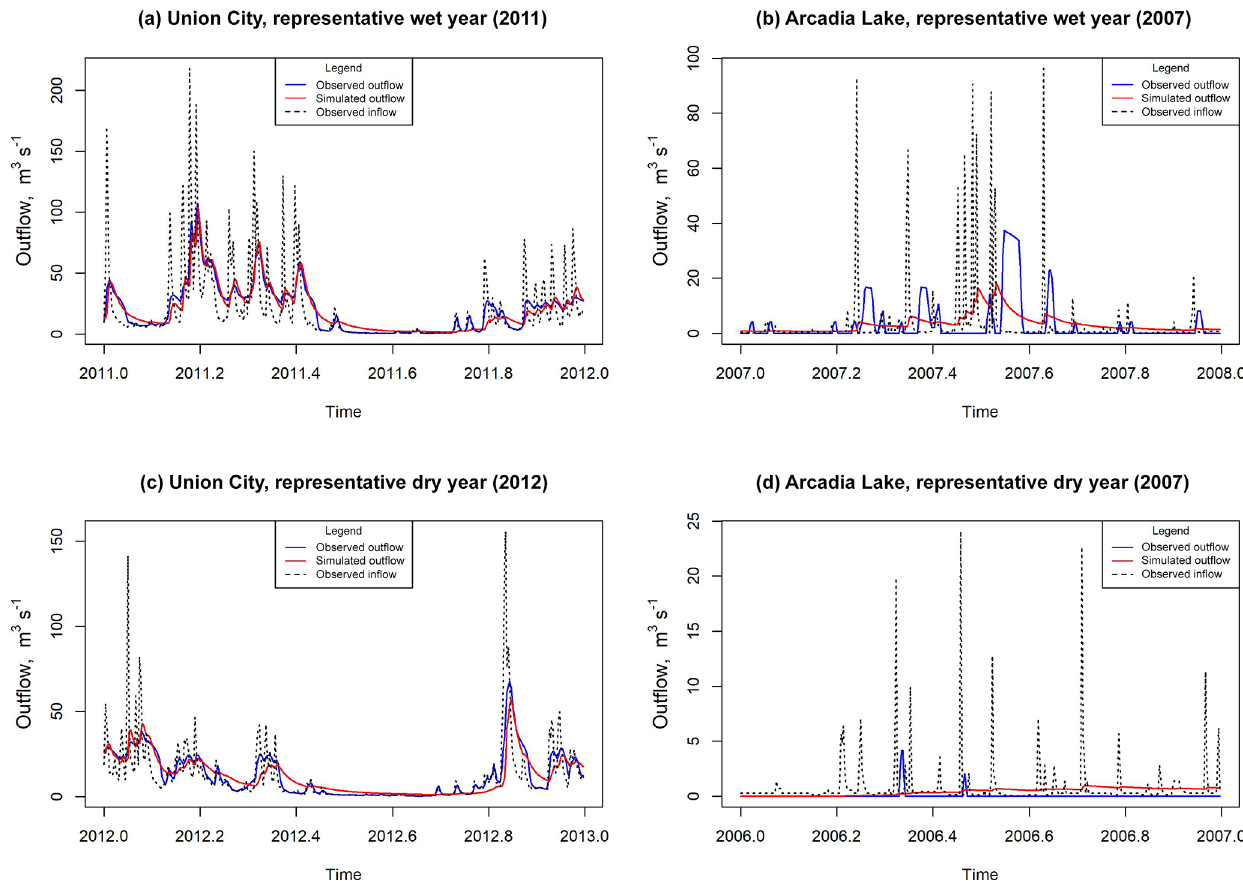
Figure 9. Two reservoirs where D03 tends to perform very well and poorly. Outflow: (a) wet year, 2011, Union City Dam; (b) wet year, 2007, Arcadia Lake; (c) dry year, 2012, Union City Dam; and (d) dry year, 2006, Arcadia